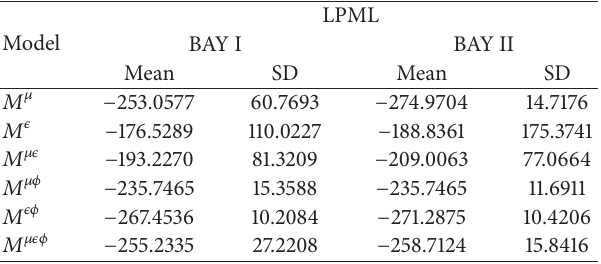
Table 3: Mean and standard deviation (SD) of LPML in the political and economic risk data.